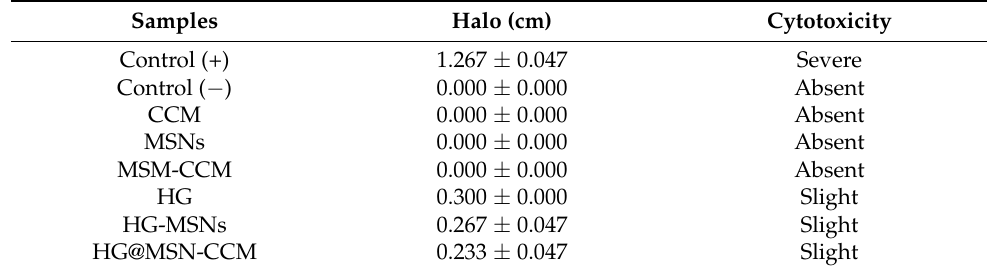
Table 4. Qualitative results of cytotoxicity study.